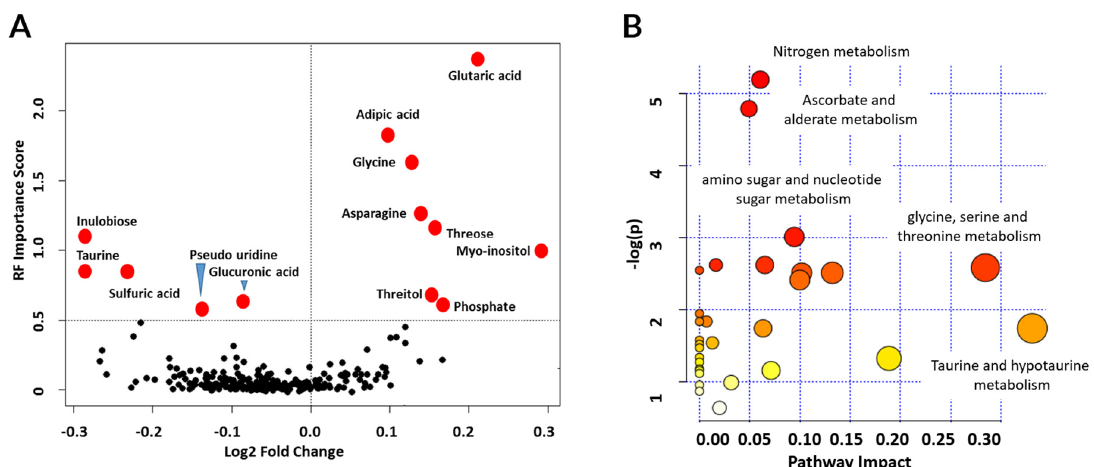
Figure 5. Metabolites and pathways significantly perturbed in KTx alloimmune injury. ( A ) Volcano plot displaying fold change and significance of metabolites. Red dots denote metabolites significant at a Random Forests importance score greater than 0.5. The right half displays metabolites in the injury group with a higher signature relative to the stable group. Some metabolites from the 9-metabolite marker panel for alloimmune injury and the 11-metabolite marker panel for AR are among the very highly perturbed metabolites labeled in red dots. ( B ) Enrichment analysis of metabolic pathways using significantly altered metabolites showed enrichment in nitrogen metabolism ( p = 0.0055), ascorbate and aldarate metabolism ( p = 0.0083), and amino sugar and nucleotide sugar metabolism ( p = 0.05) as significantly enriched pathways. The y-axis represents the p -values as the negative of their natural logarithm.